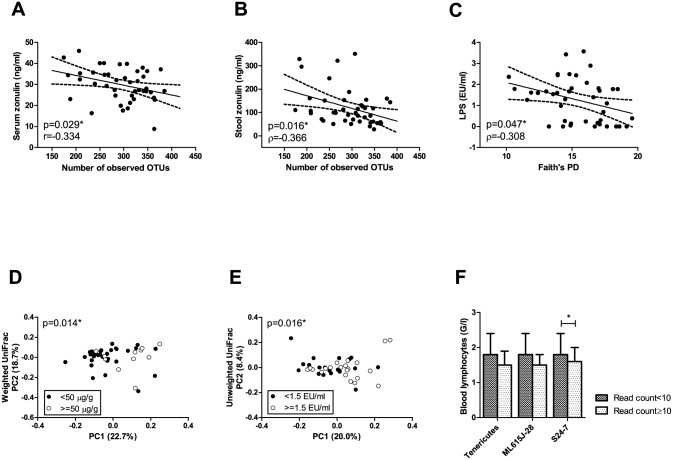
Association of microbiome parameters with parameters of gut barrier integrity and inflammation.LPS: lipopolysaccharide (= endotoxin), hsCRP: high-sensitivity C-reactive protein. Dots represent individual study subjects. Median and IQR are plotted. The number of samples with detectable levels of the relevant taxa (read count ≥10) was 12/43 for Tenericutes, 5/43 for ML615J-28, and 10/43 for S24-7.